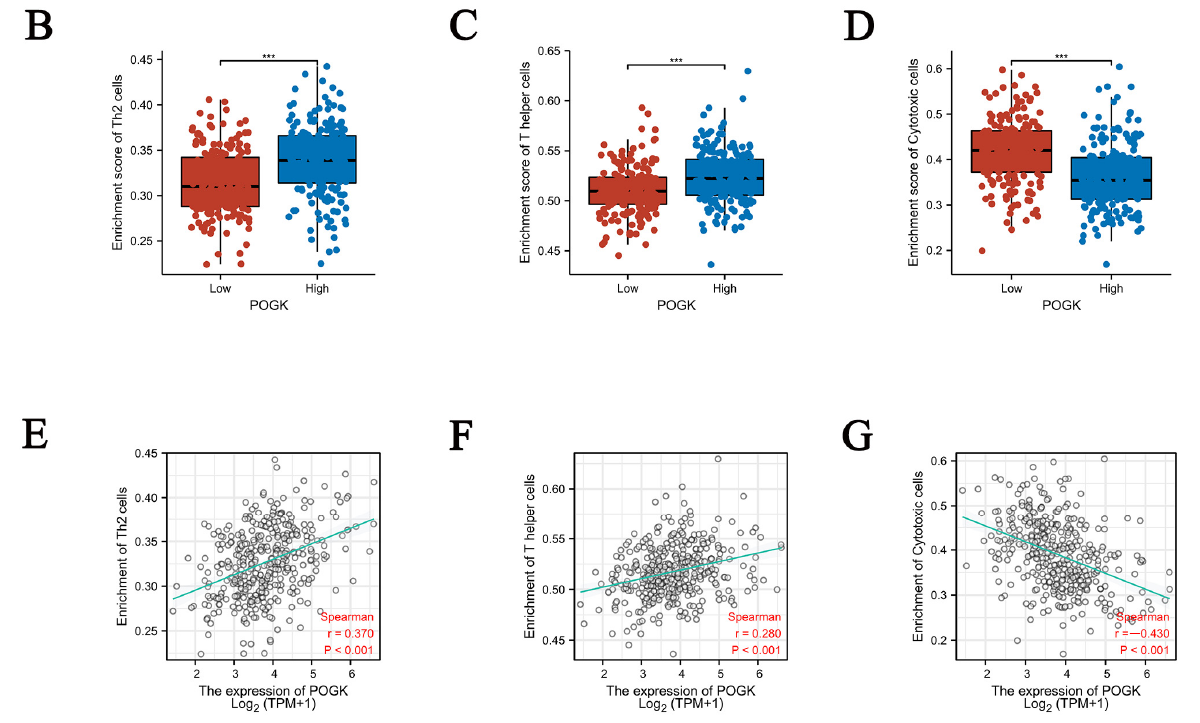
Figure 8. Correlation between POGK expression and immune cells in the tumor microenvironment. ( A ) Correlation between the relative abundances of 24 immune cells and POGK expression level. The absolute value of Spearman R was shown by the size of the dots. ( B – G ) Scatter plots and correlation charts showing the difference in Th2 cells, T helper cells, and cytotoxic cell enrichment levels between high and low POGK expression level groups. ***: p <